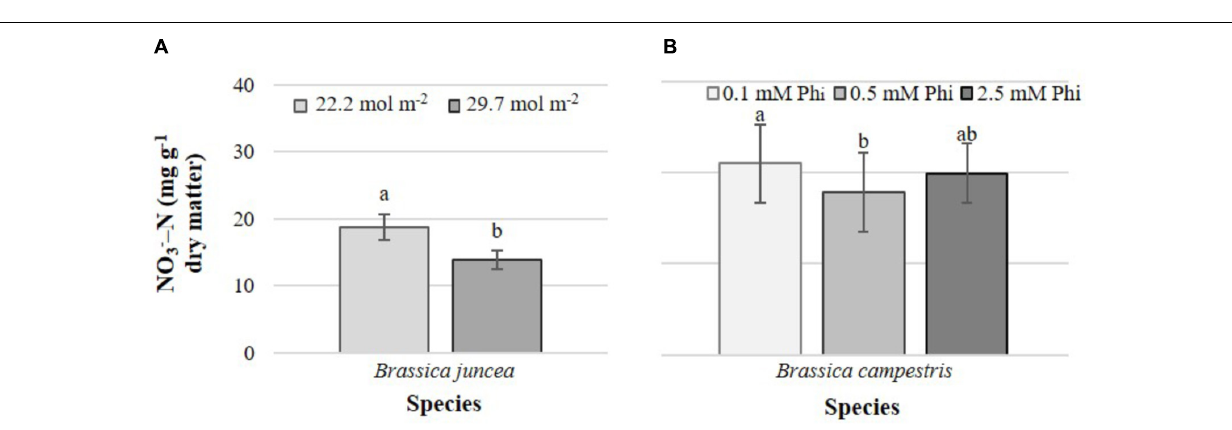
FIGURE 4 | Effects of mean daily photosynthetically active radiation (PAR) and phosphite (Phi) on nitrate concentration in B. juncea cv. Red Giant (A) and B. campestris cv. Mibuna Early (B) , respectively. Means ± SD with different letters in each subfigure indicate significant differences at P ≤ 0.05 (Tukey’s test).